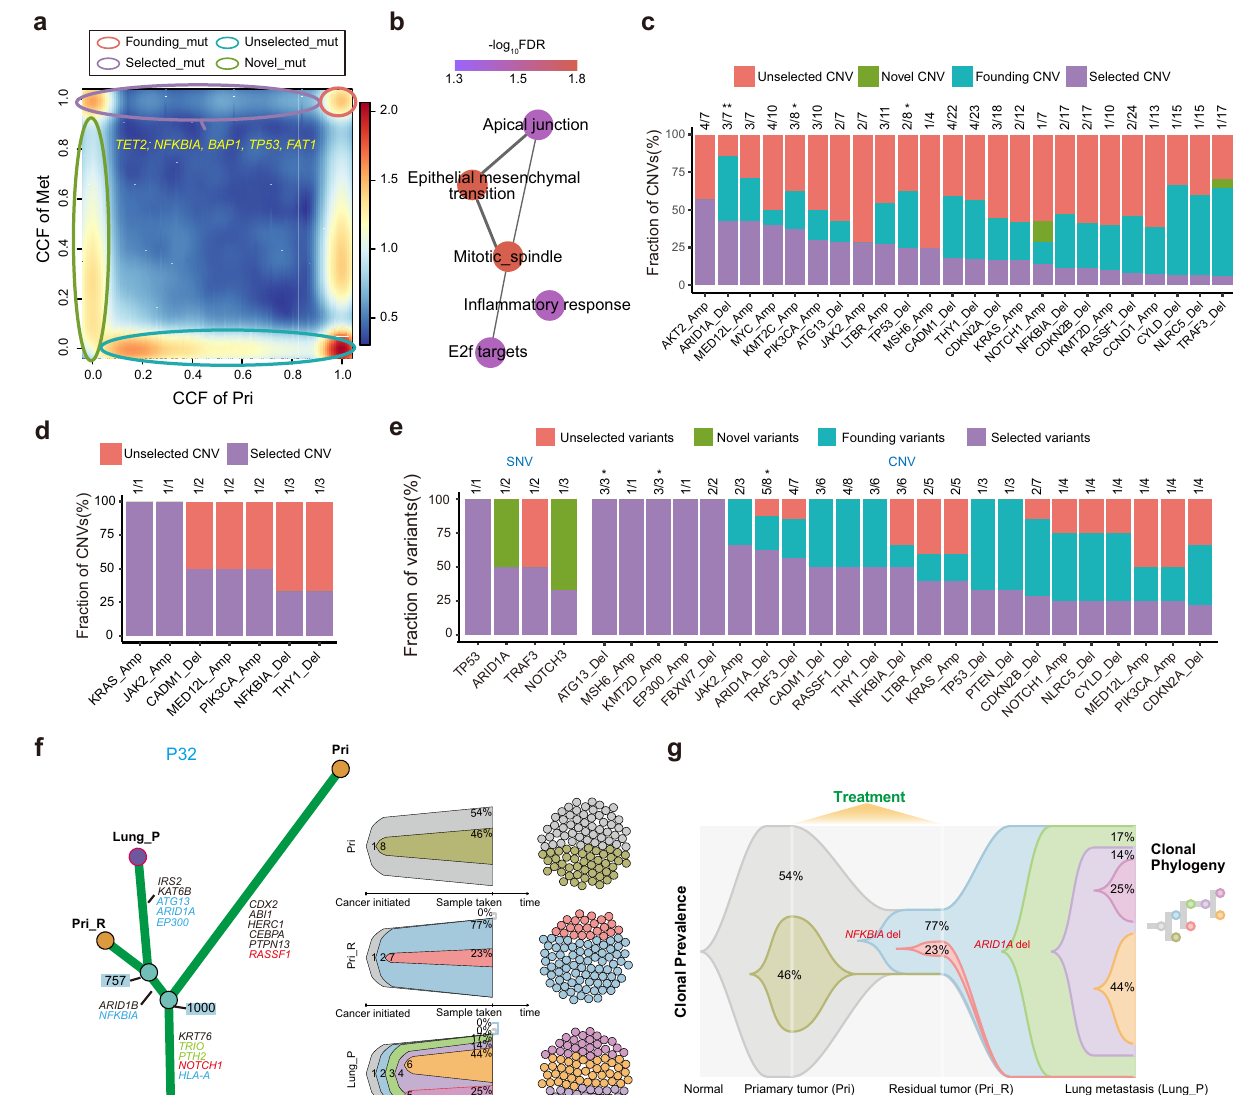
Fig. 2 | Driver events during NPC metastasis. a Scatter plot indicating different variant groups during metastasis. Each variant is measured by CCFs in the primary tumouranddistantmetastasisfromthesamepatient.Thecolourrangere fl ectsthe mutation density. Red circles, founding variants that are clonal both before and aftermetastasis;purplecircles,selectedvariantsthatareundetectableorsubclonal before metastasis but clonal after metastasis; blue circles, unselected variants that are clonal or subclonal before metastasis and undetectable after metastasis; and green circles, novel variants that are subclonal after metastasis but undetectable before metastasis. Predicted driver genes harbouring SSNVs are marked. b Reactome pathway enrichment of mutated genes in the “ selected ” group. c DistributionofvariantgroupsduringmetastasisaccordingtokeyNPCCNVs.Only selected CNVs are shown, and the number of selected CNVs was annotated.